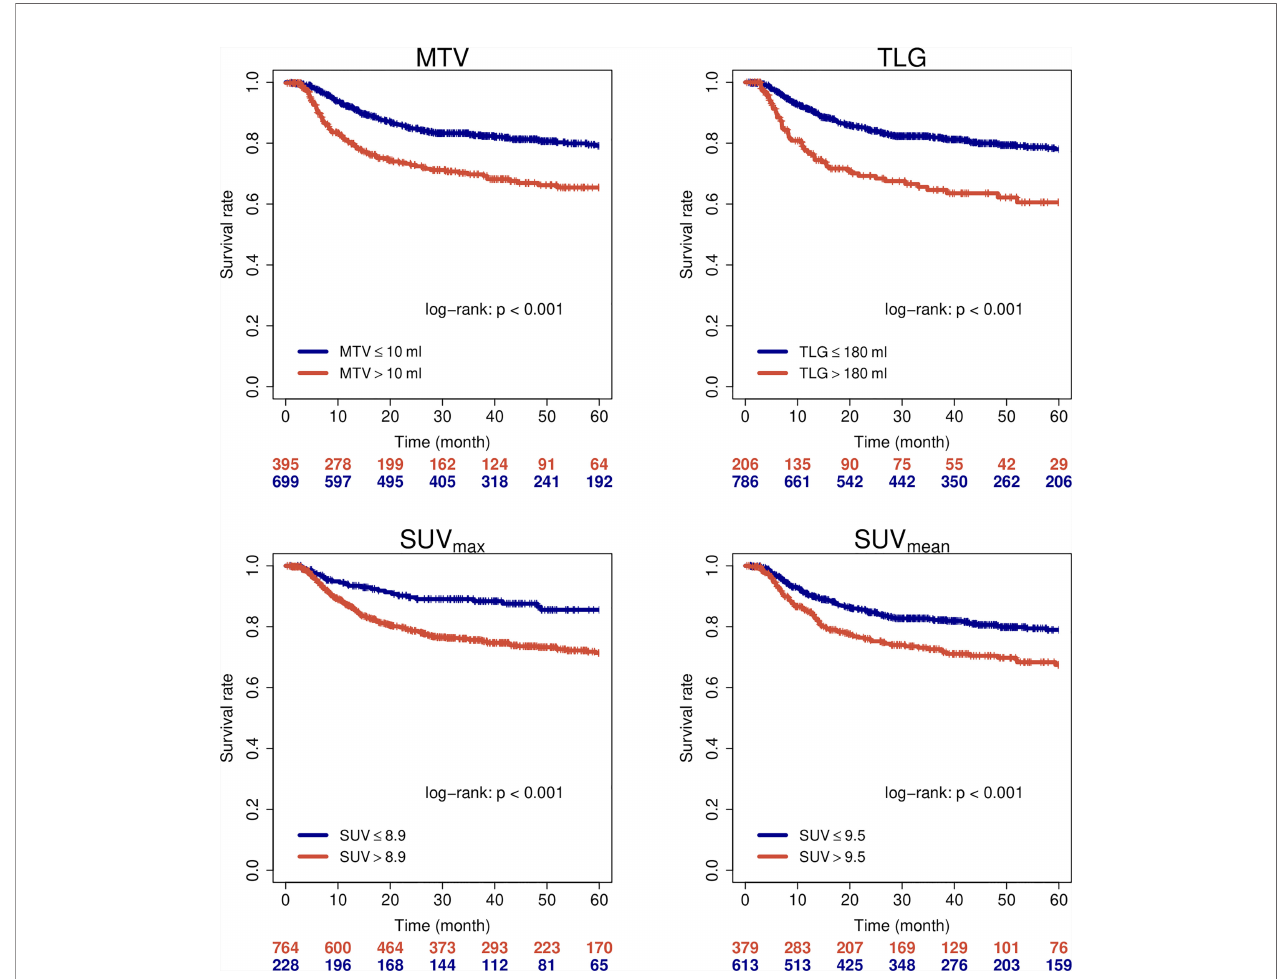
FIGURE 2 | Loco-regional control of all patients when strati fi ed by PET